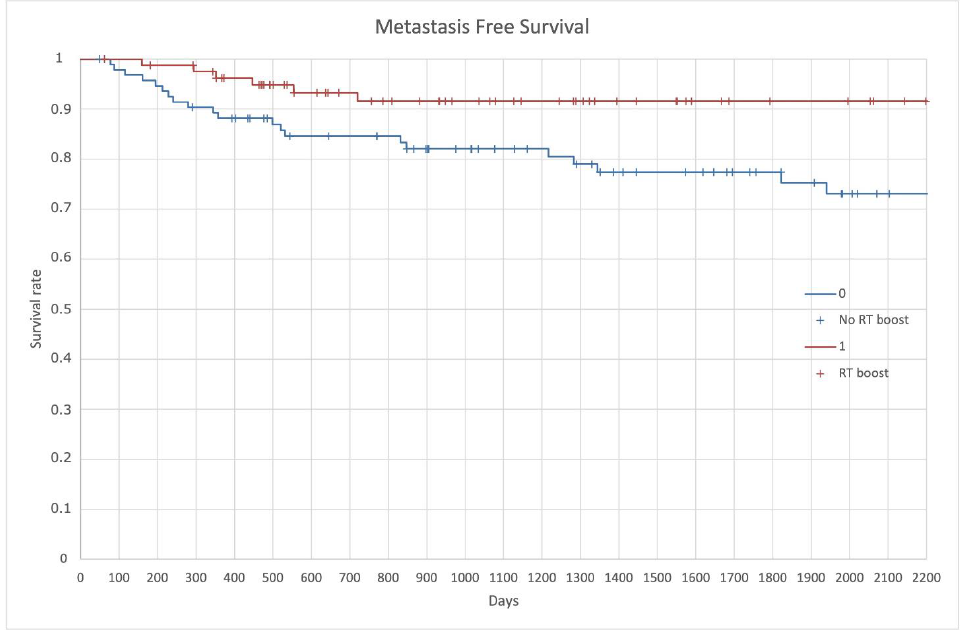
Figure 6. Metastasis Free Survival (MFS).